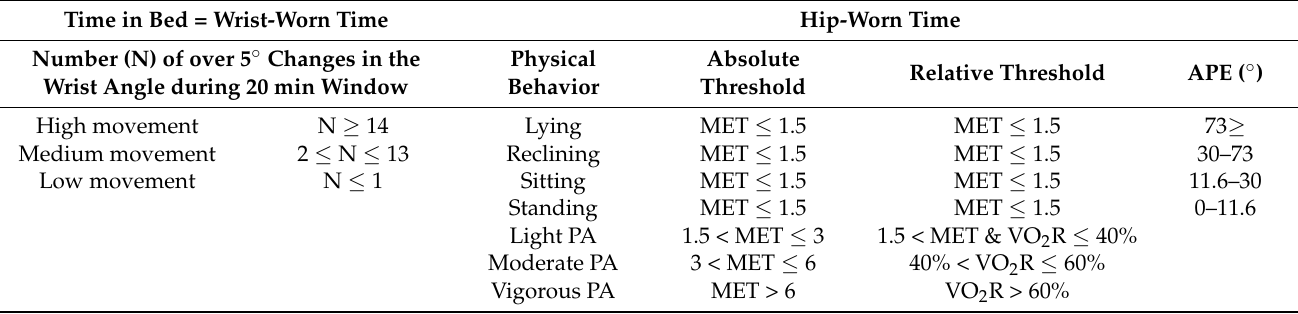
Table 1. Accelerometer-derived parameters of the physical